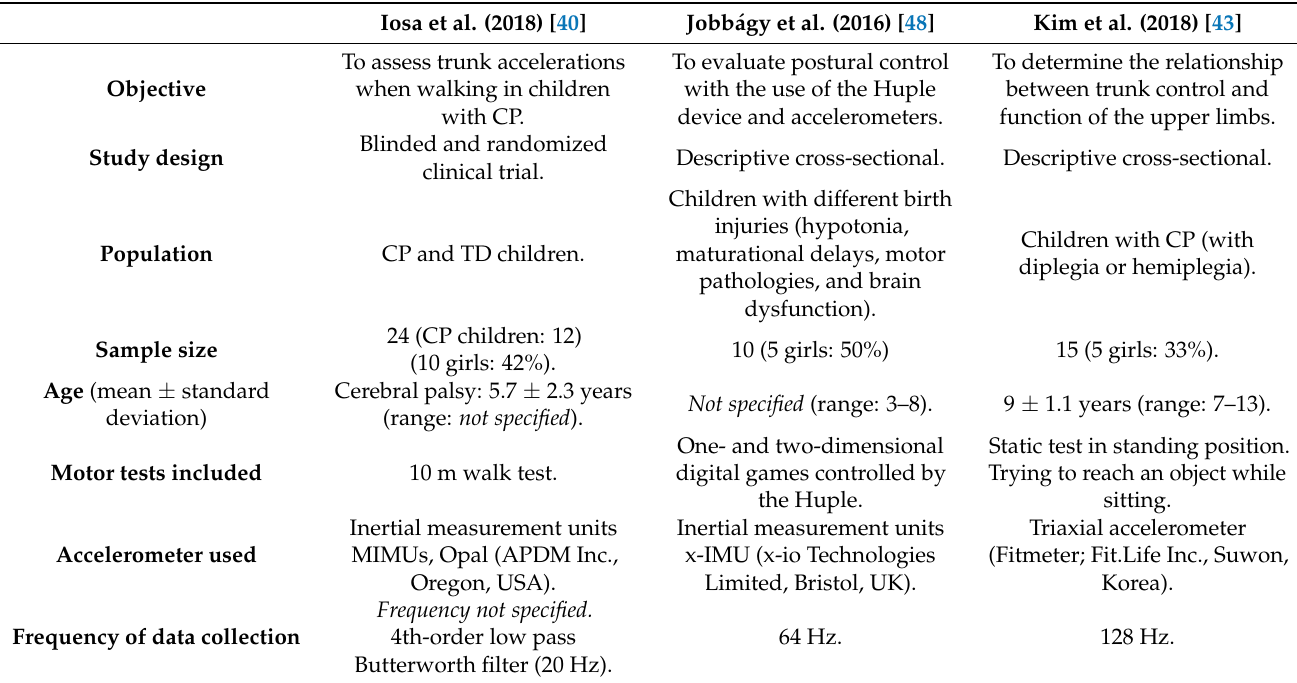
Table 3. Methodological characteristics of the articles